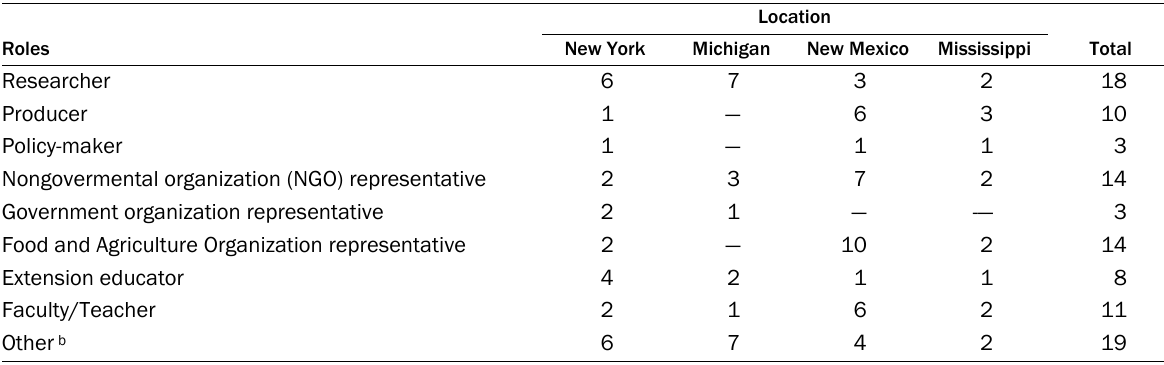
Table 1. Professional Roles in Food Systems Work of Workshop Participants a